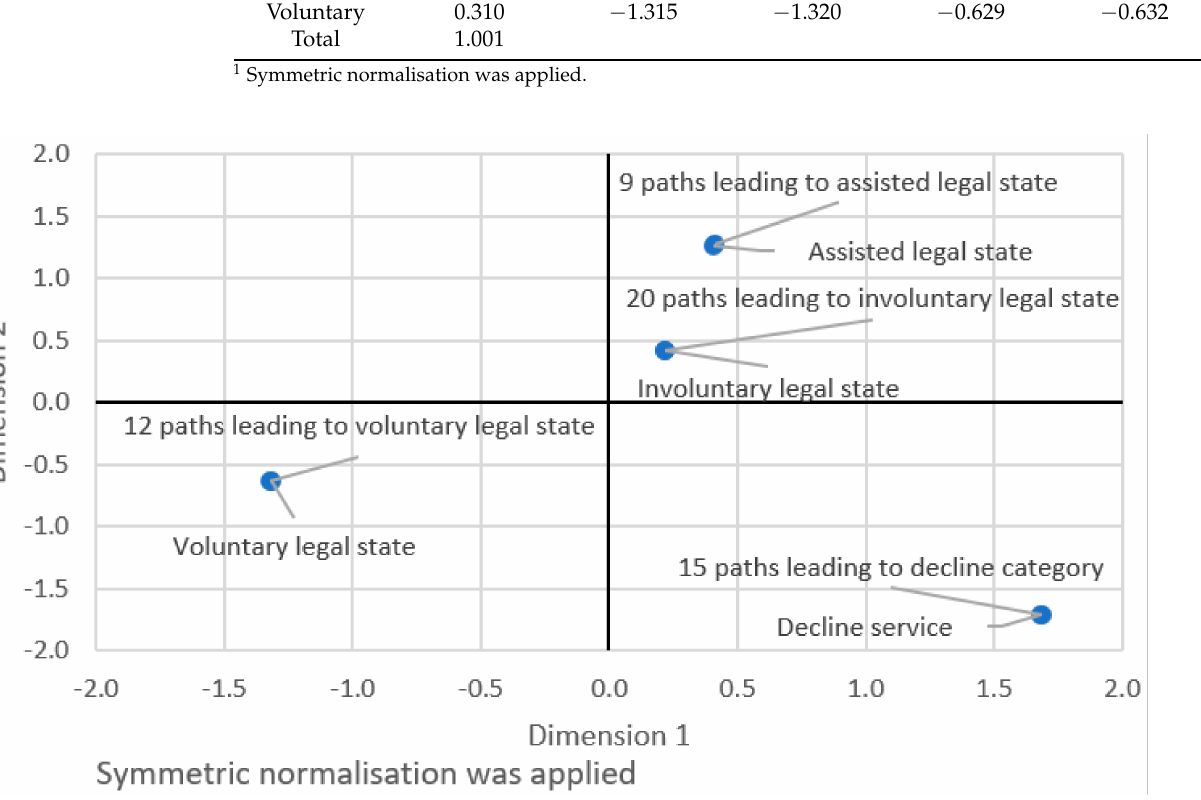
Figure 1. Correspondence model between legal states and decision